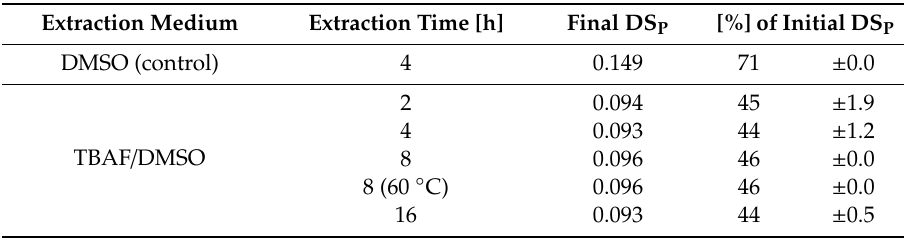
Table 2. DS P values of hwPHK-P (initial DS P = 0.209) after extraction with DMSO or a solution of 16.6 and for di ff erent time periods. The range of variation indicates the 95% confidence interval ( n =